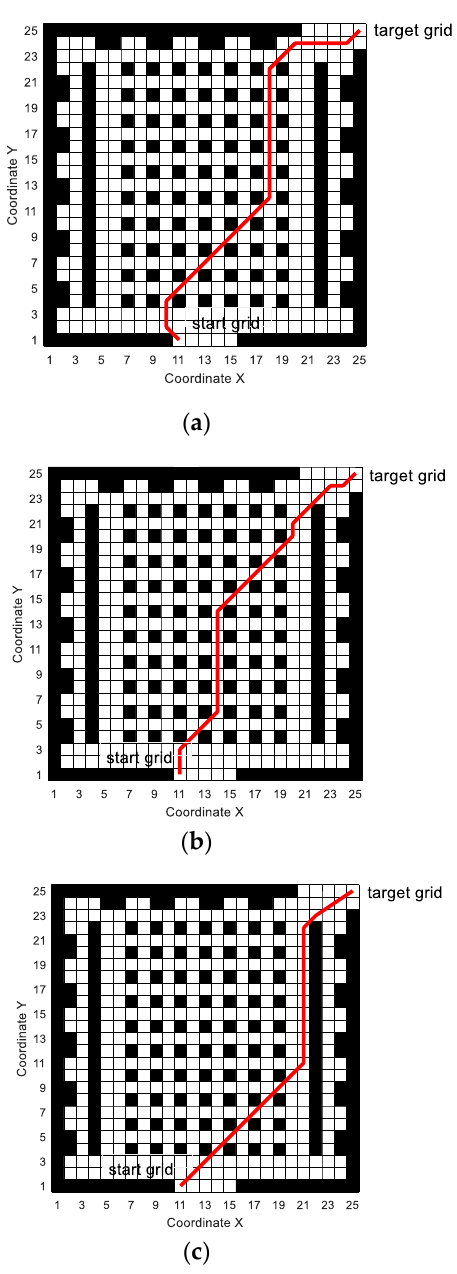
Figure 13. Simulated paths of the three algorithms. ( a ) SGA; ( b ) PCDA; ( c ) MPMGA.